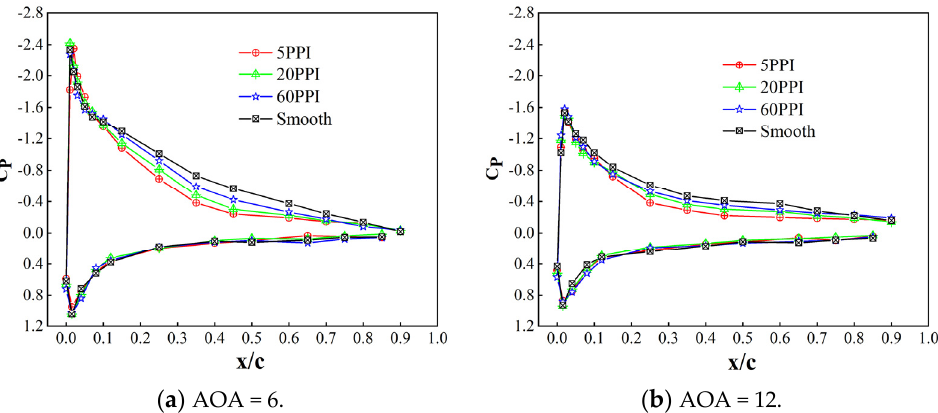
Figure 6. Pressure distribution of airfoil-laying porous media of different pore densities.